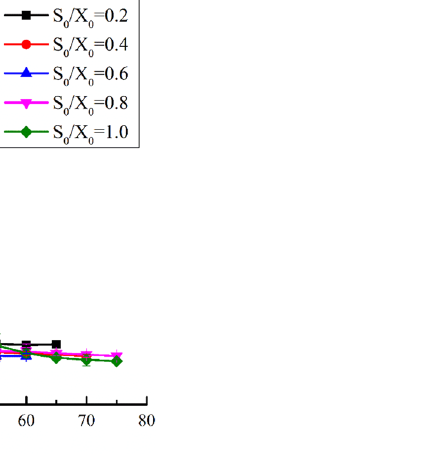
Figure 2. OUR curve of urban wastewater under different S 0 /X 0